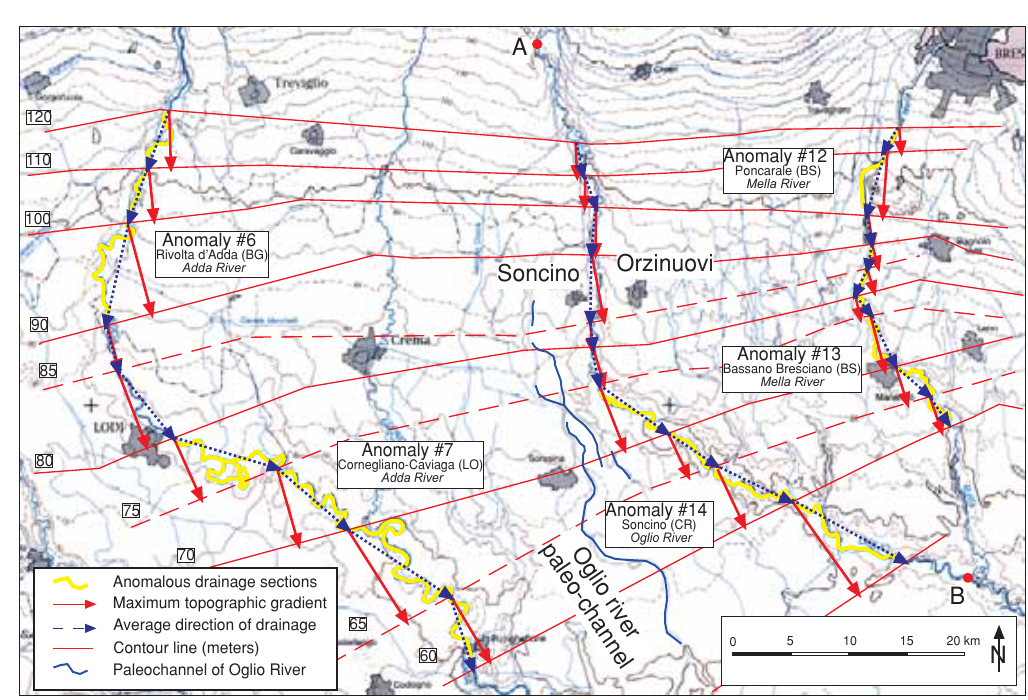
Fig. 4. Outline of the method used to detect drainage anomalies in the Po Plain. The figure shows an area locat- ed north of the Po River, between the Adda River and the Mella River. Straight-line segments at contour line inter- vals ranging between 5 and 10 m were constructed from the Map of Relief and Vertical Movements of the Po Plain (MURST, 1997b). Solid red arrows and dashed blue arrows show topographic gradients and actual average drainage directions, respectively. We defined a drainage anomaly as a (cid:42) 10° divergence between the two vectors. Anomaly # . 14 on the Oglio River is analysed in detail. A and B mark the ends of profiles shown in fig.